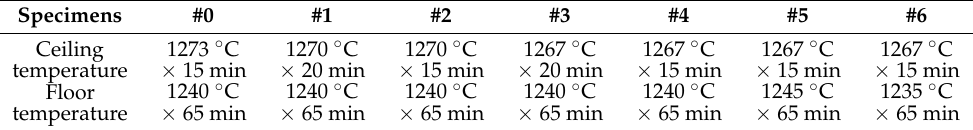
Table 3. The designed sintering parameters for variable temperature SLPS. Specimens #0 #1 #2 #3 1273 ◦ C Ceiling × 15 min temperature 1240 ◦ C Floor × 65 min temperature